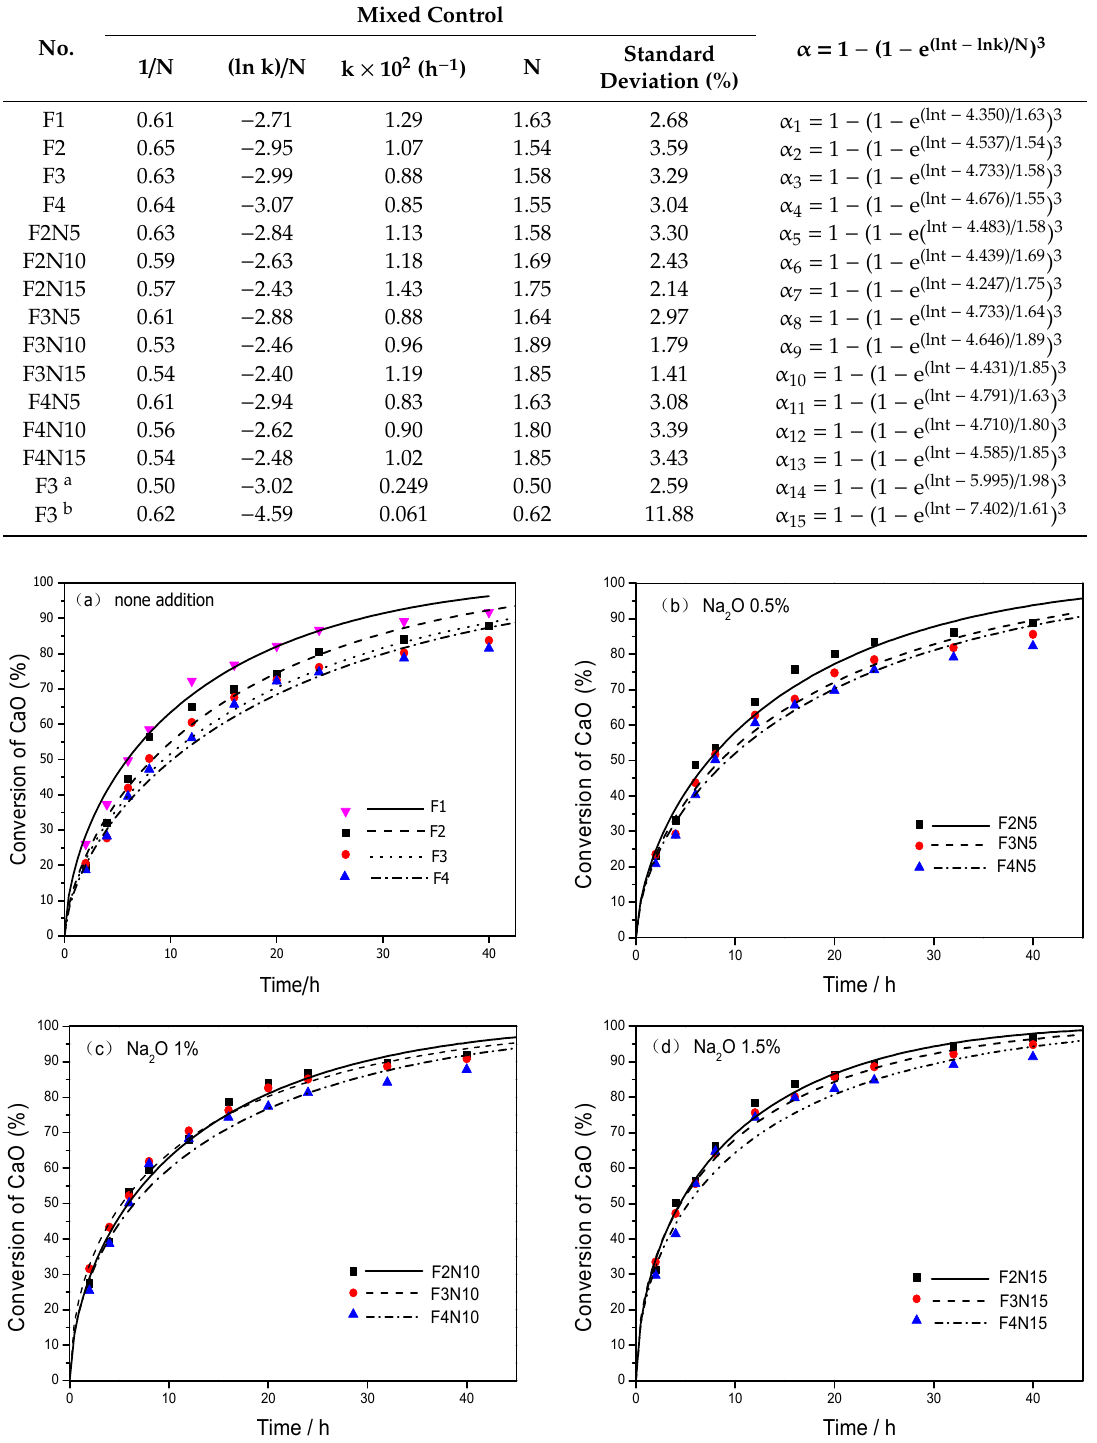
Figure 1. Experimental and simulated absorption rates of CaO under different conditions: ( a ) None addition; ( b ) the dosage of Na 2 O is 0.5%; ( c ) the dosage of Na 2 O is 1.0%; ( d ) the dosage of Na 2 O is 1.5%.